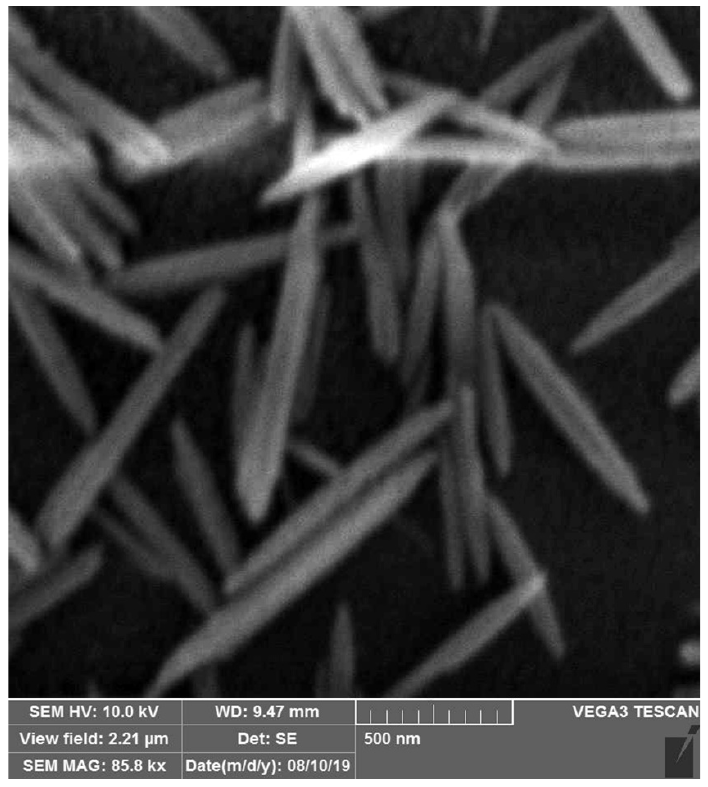
Figure 8. SEM image of ZnO nanorods.